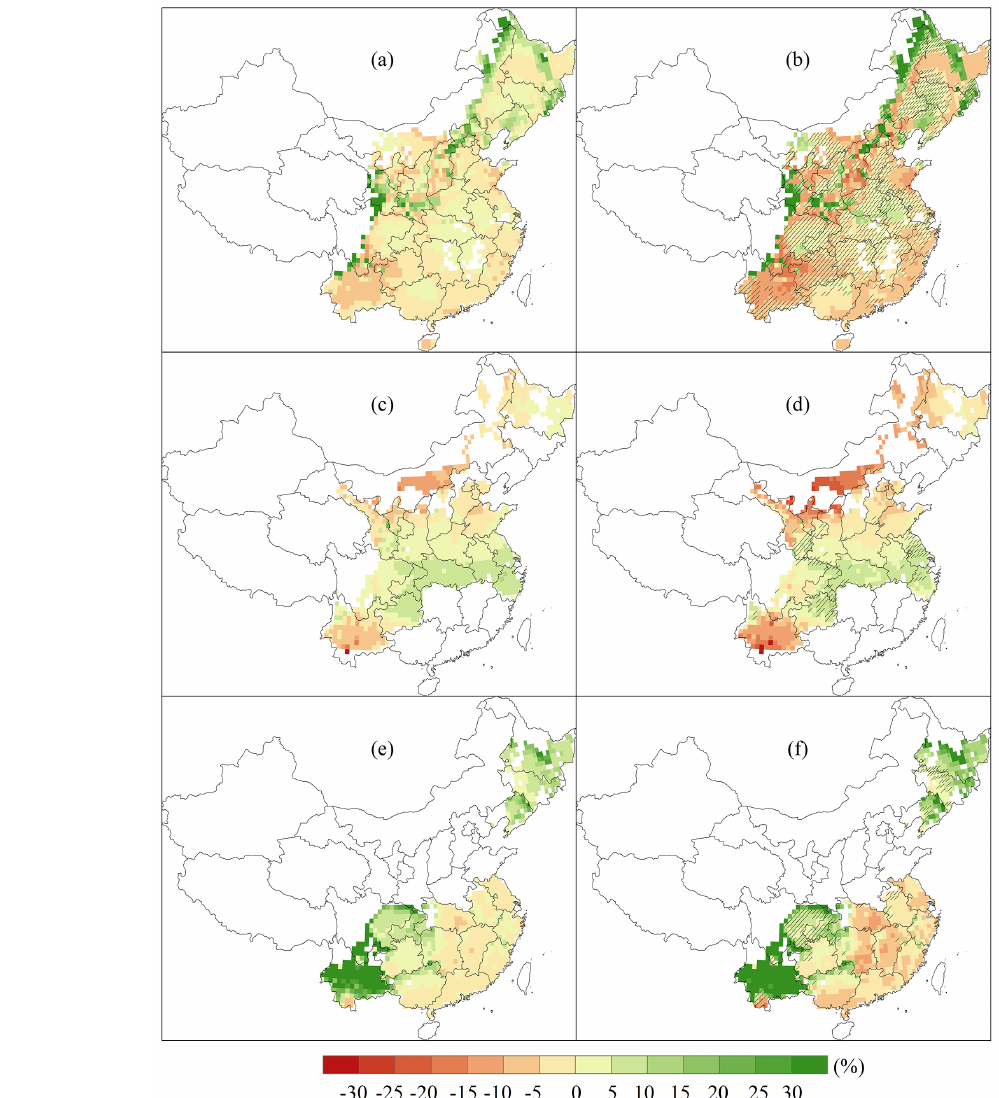
Figure 4. Median changes in projected yield for maize (a, b) , wheat (c, d) and rice (e, f) during 2106–2115 under the 1.5 ◦ C warming (a, c, e) and 2.0 ◦ C warming (b, d, f) scenarios relative to 2006–2015, without taking the CO 2 fertilization effect into account. Hatching indicates the areas where the differences between the 1.5 and 2.0 ◦ C warming scenarios are not significant ( P > 0 . 05).